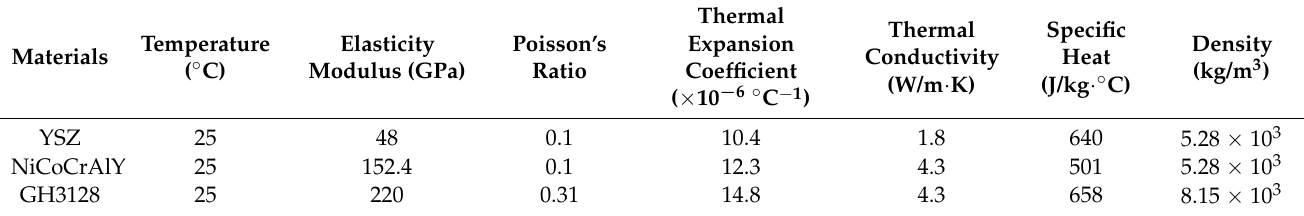
Table 1. Material properties of YSZ, NiCoCrAlY and GH3128 [23–26].